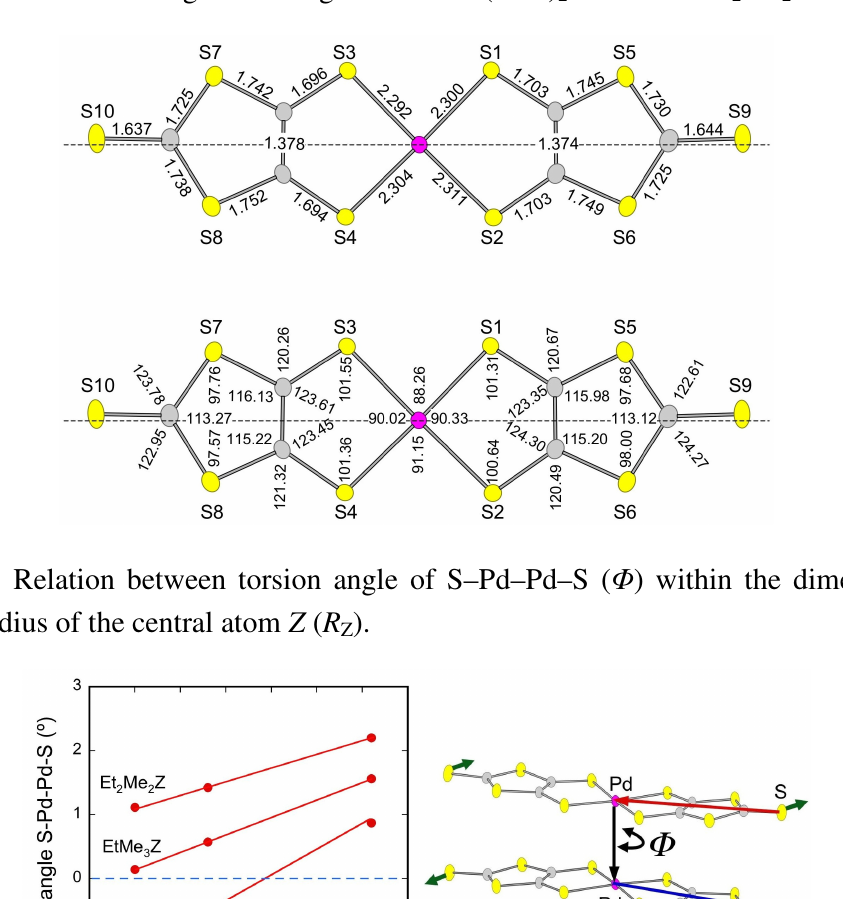
Figure 9. Bond lengths and angles of the Pd(dmit)